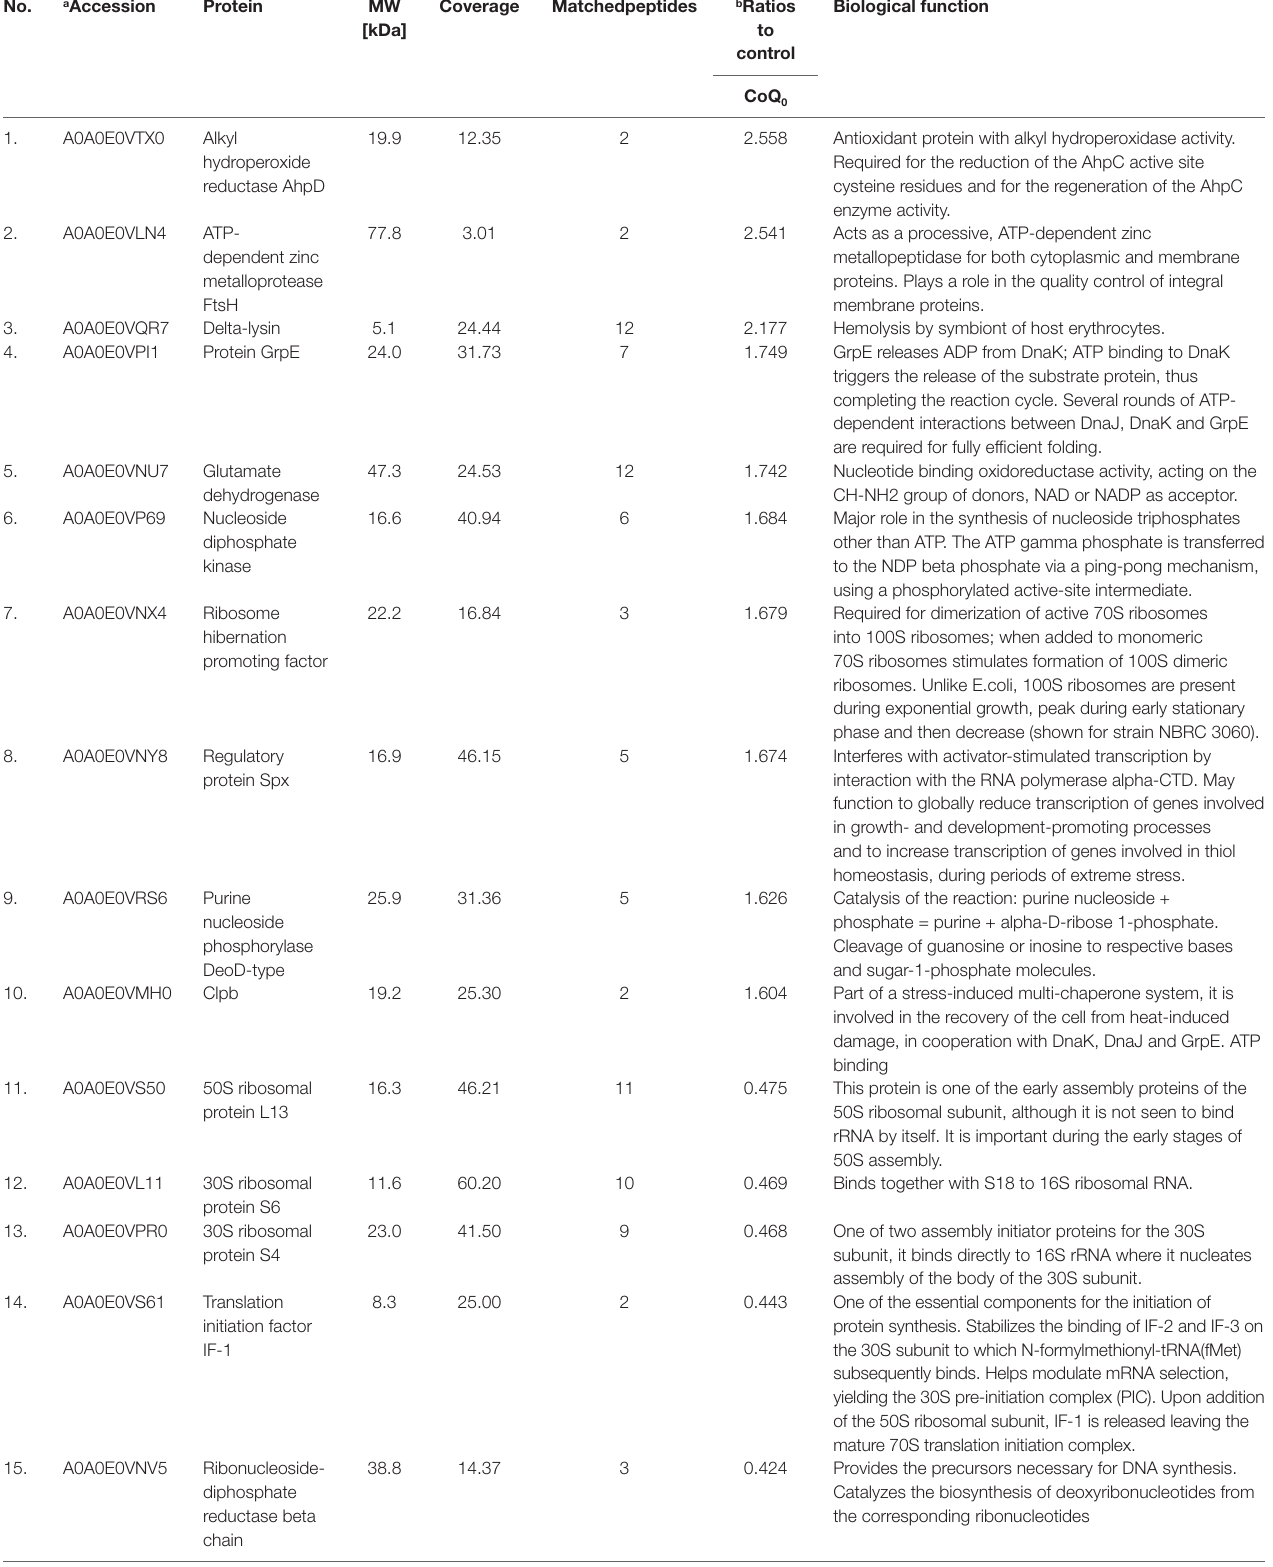
TABlE 3 | Quantitative proteomics by iTRAQ labeling. Differentially expressed proteins follow the treatment of CoQ 0 .